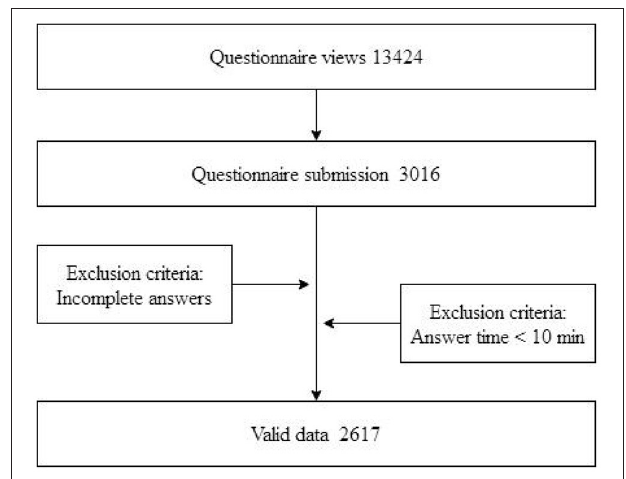
FIGURE 2 | Flowchart of data